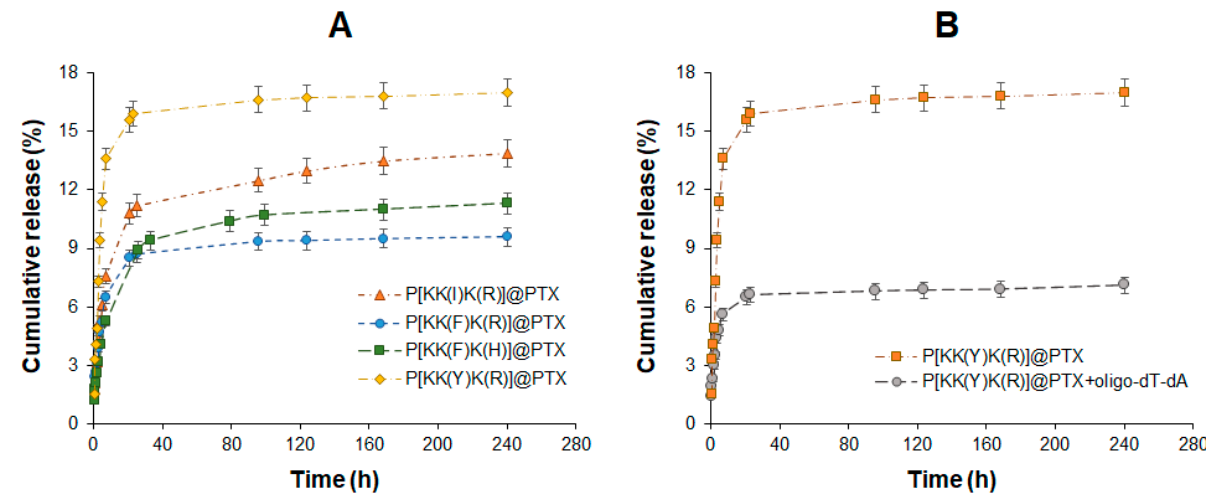
Figure 9. PTX release pro fi les from single ( A ) and double ( B ) component formulations (0.01 M PBS, pH 7.4, 37 °C). pH 7.4, 37 ◦